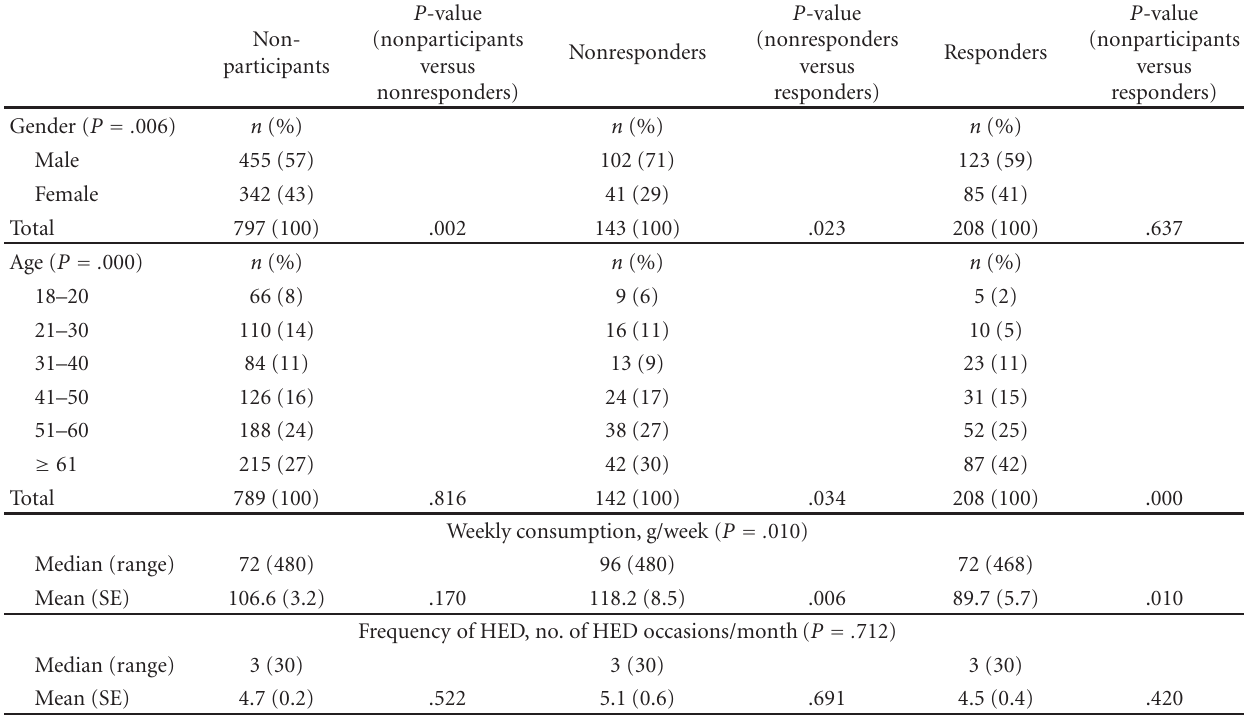
Table 1: Comparison of sociodemographic and drinking characteristic between nonparticipant, responders and nonresponders among those patients who were referred to the test by the sta ff .